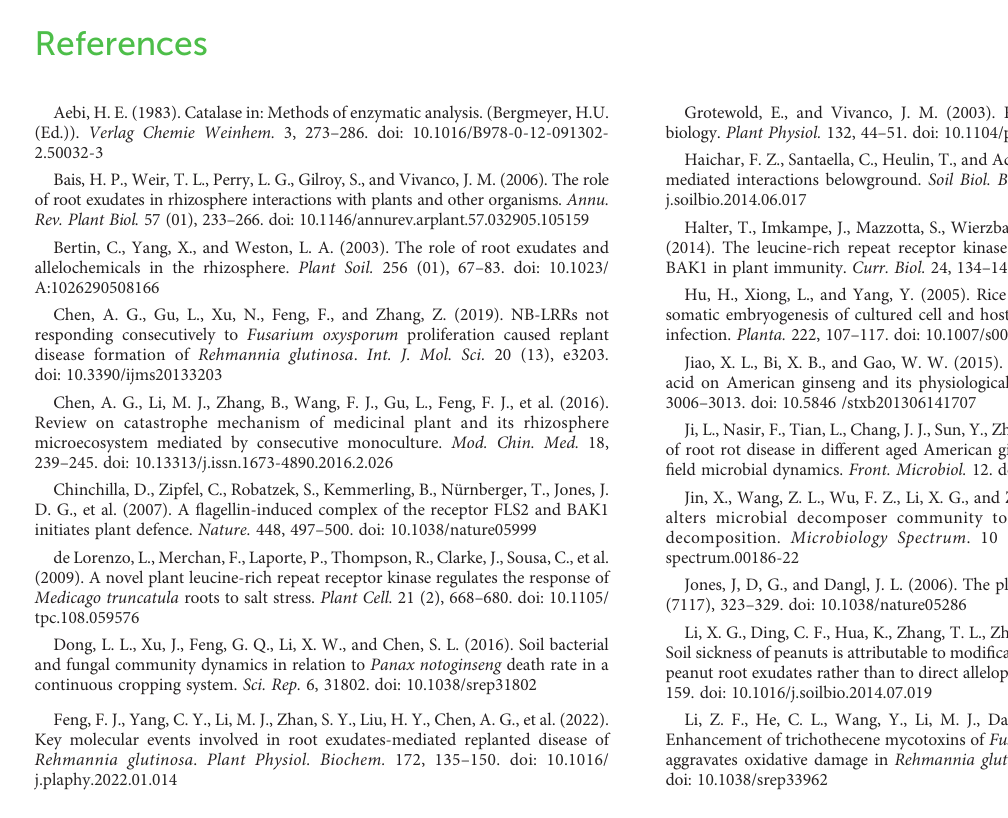
Trypan blue staining analysis of root segments with transient overexpression and RNAi of nine RgLRRs under the treatments of root exudates, F. oxysporum and comprehensive stress of root exudates and F. oxysporum . CK, Empty vector as control; RE, the treatment of root